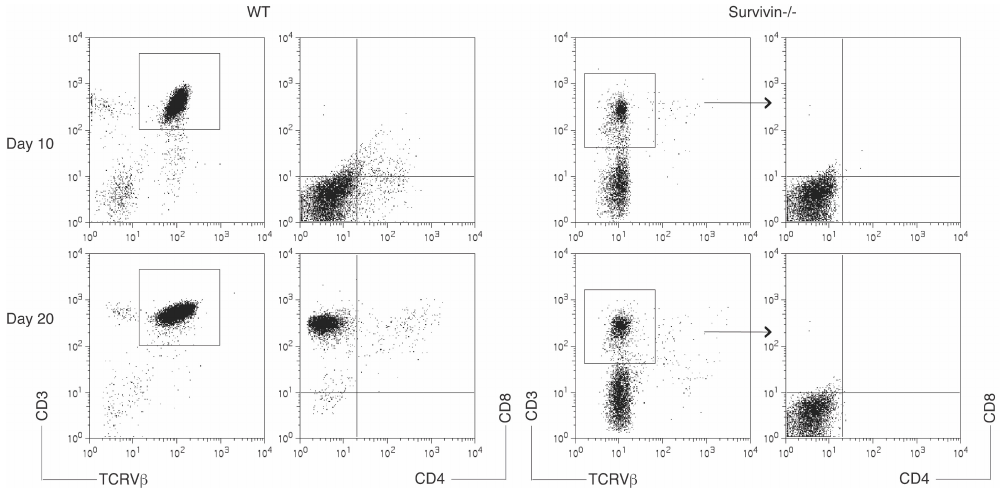
Figure 6. Survivin-deficient HSCs show reduced ability to differentiate into T cells in response to Notch signaling. The bone marrow–derived CD117 + HSCs from the wild type or survivin − / − mice were co-cultured with the OP9-DLL1/DLL4 cells and cytokines (IL-7 and Flt3L). Differentiation of HSC-T cells was examined by flow cytometric analysis for the protein expression in the HSC-derived cells on days 10 and 20. CD3 + TCRV β + cells were gated as indicated, and analyzed for the expression of CD4 and CD8. Data shown are representative of three identical experiments.